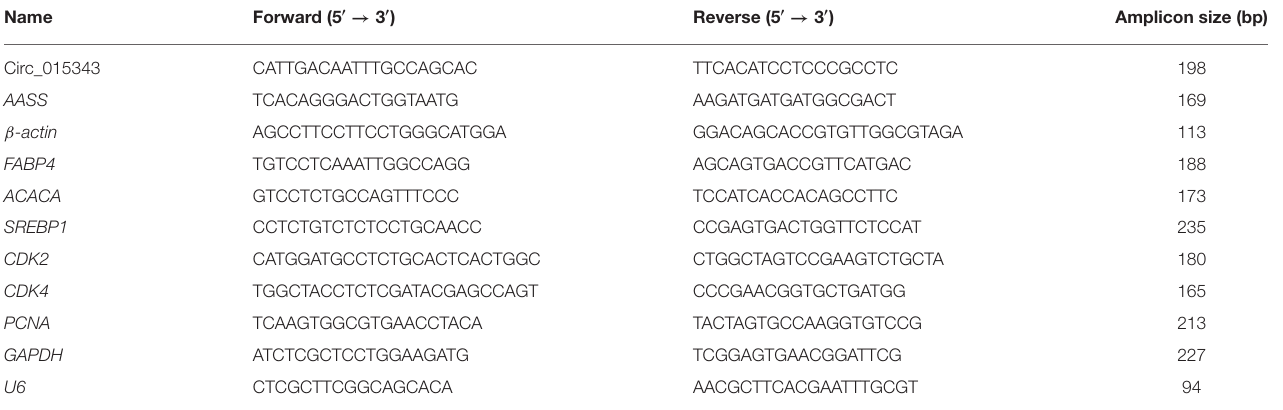
TABLE 1 | The information of PCR